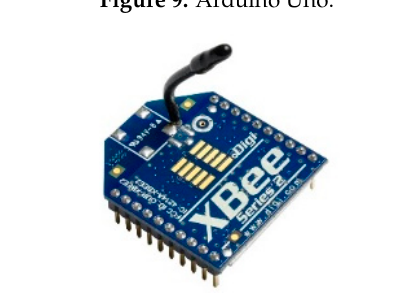
Figure 10. Digi XBee serial 2.